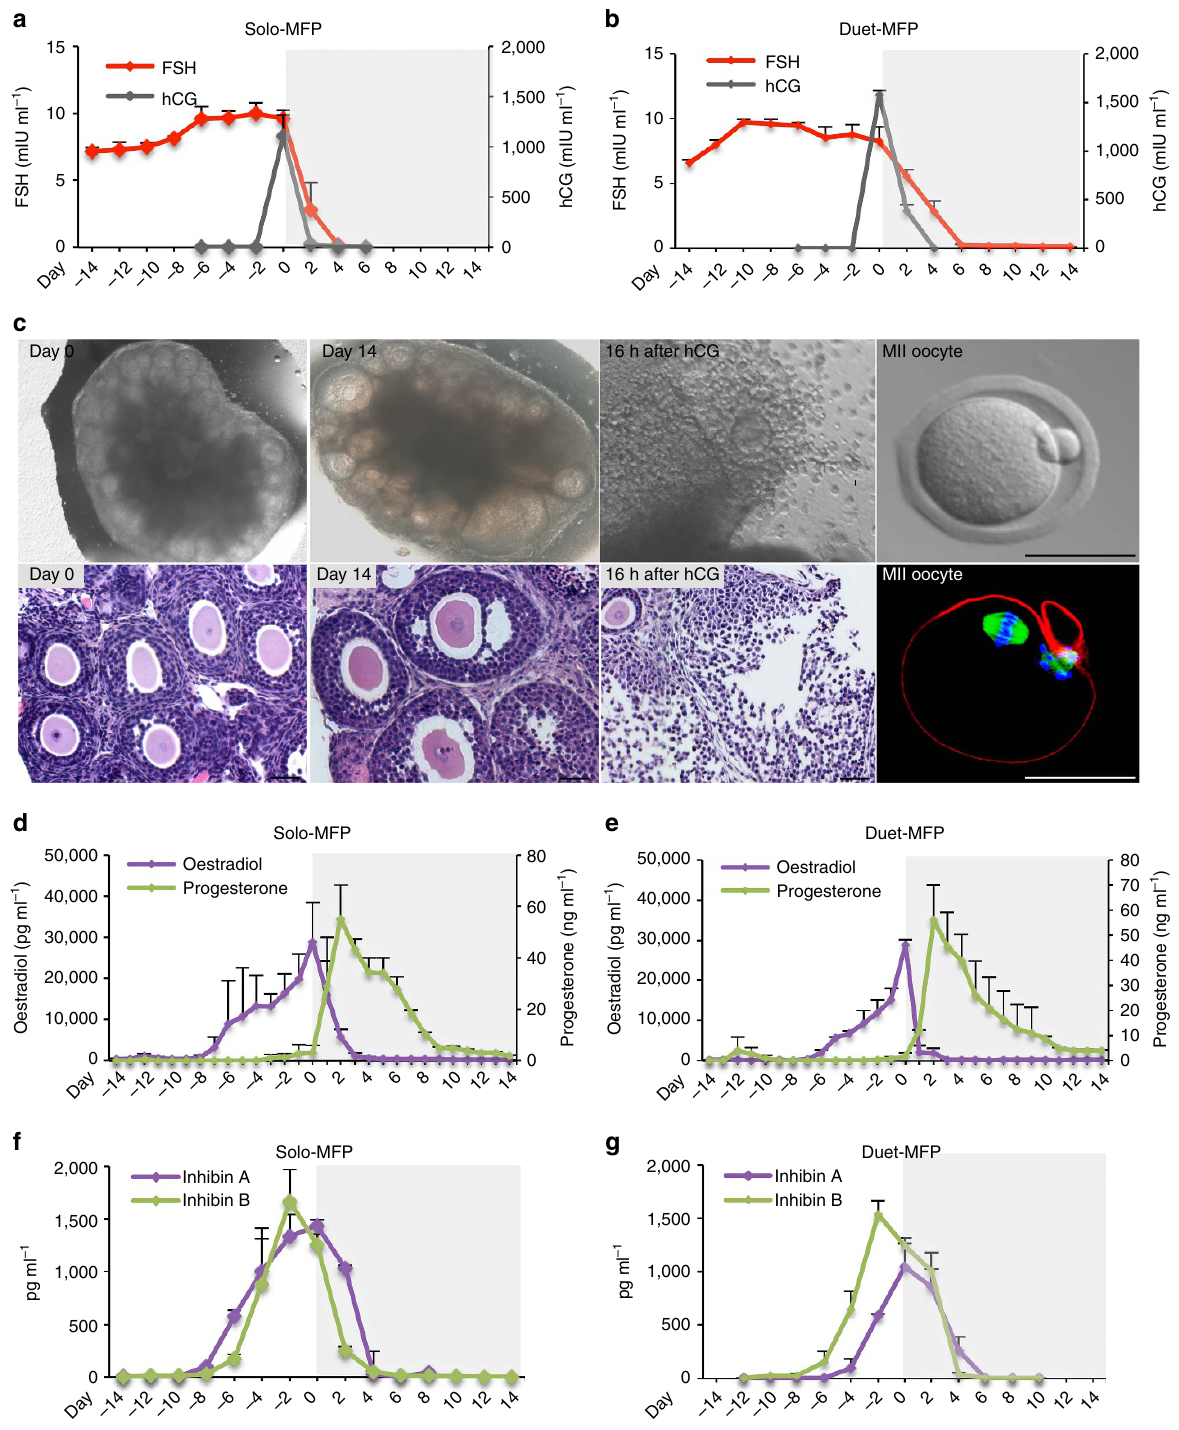
Figure 4 | Ovarian explant cultures supported follicle development and hormone secretion in the Solo-MFP and Duet-MFP. ( a , b ) Concentrations of pituitary hormones, FSH and hCG, in the acceptor module during 28-day microfluidic culture. ( c ) Ovarian explants were cultured in the Solo-MFP and Duet- MFP, in which follicles developed from the pre-antral to antral stage, and extruded MII oocytes following hCG stimulation. ( d , e ) Secretion of oestradiol (E2) and progesterone (P4) in the Solo-MFP and Duet-MFP. ( f , g ) Secretion of inhibin A and inhibin B in the Solo-MFP and Duet-MFP. Graphs in a , b , d – f display average þ s.d. Scale bar, 50 m m. n ¼ 3–5 replicates for the Solo-MFP and Duet-MFP microfluidic cultures.